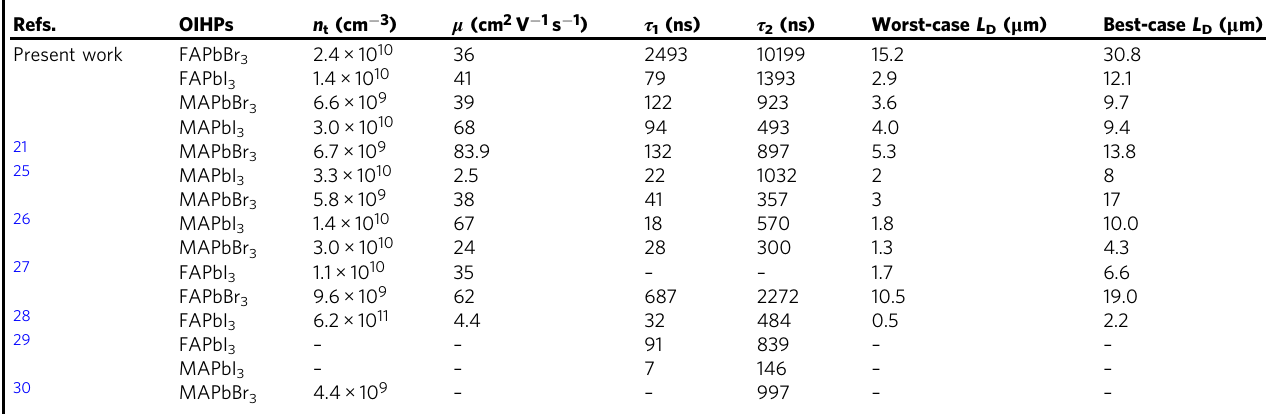
Table 1 Some typical physical properties of the OIHPs single crystals via the PC approach.